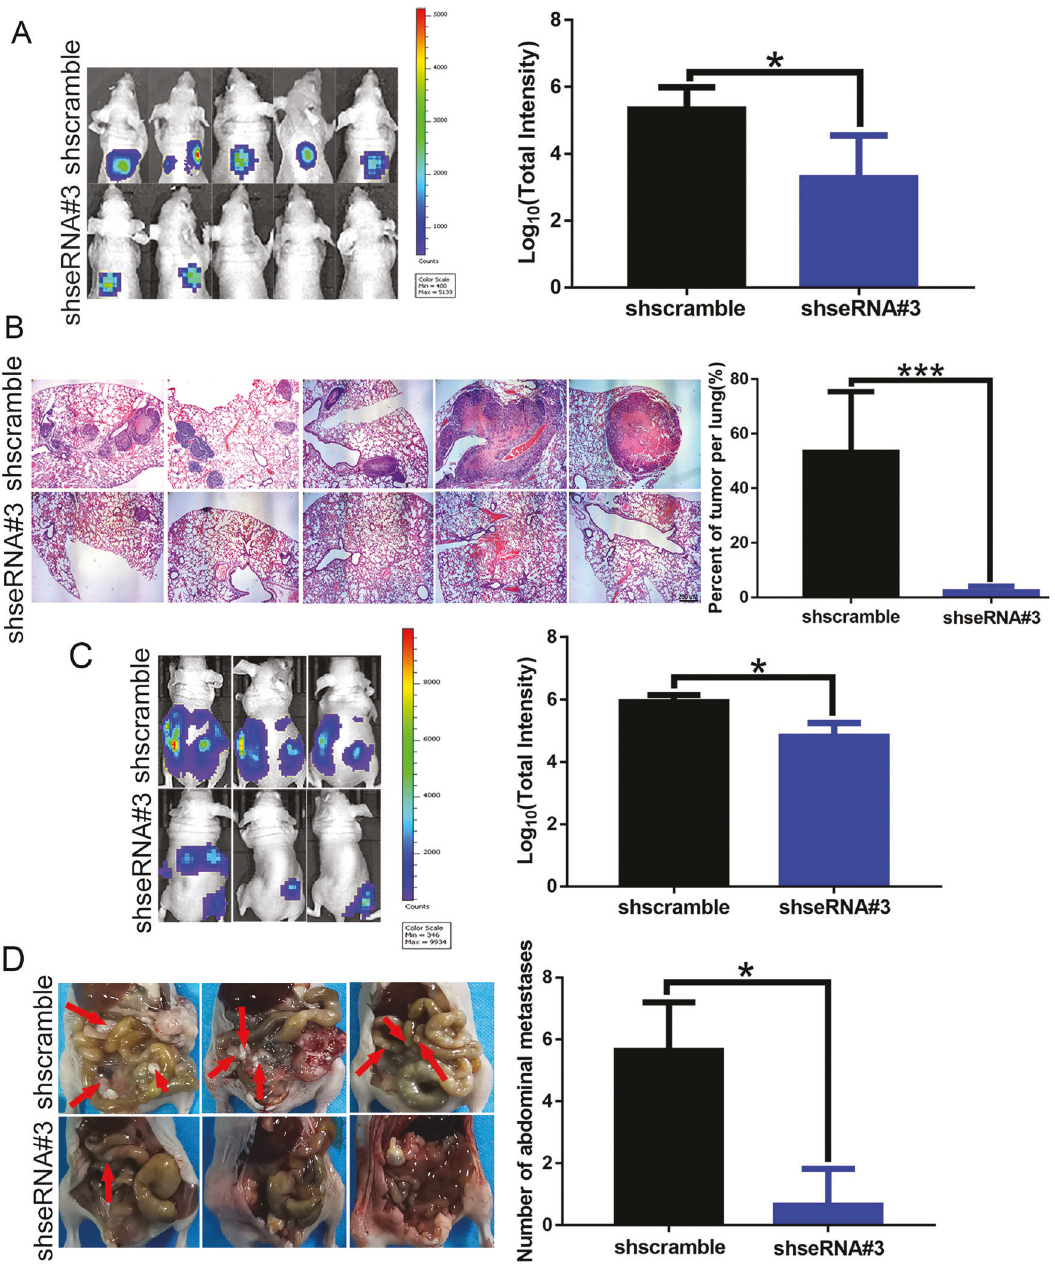
Fig. 7 seRNA LOC100506178 promoted the invasion and metastasis of NPC cells in vivo. A A total of ten nude mice were randomly allocated to the S18-shseRNA#3 group ( n = 5) or the shscramble group ( n = 5). Cells were injected into the tail vein of nude mice, and the luminescence intensity of lung metastases was analyzed in vivo using an in vivo small animal imaging system. B Hematoxylin-eosin (HE) staining was used to detect the percent of tumor metastases per lung. C A total of six nude mice were randomly divided into the S18- shseRNA#3 group ( n = 3) and the shscramble group ( n = 3). Cells were injected into the abdominal cavity of nude mice, and the luminescence intensity was analyzed. D The number of abdominal cavity metastases was analyzed. *** P < 0.001; * P <